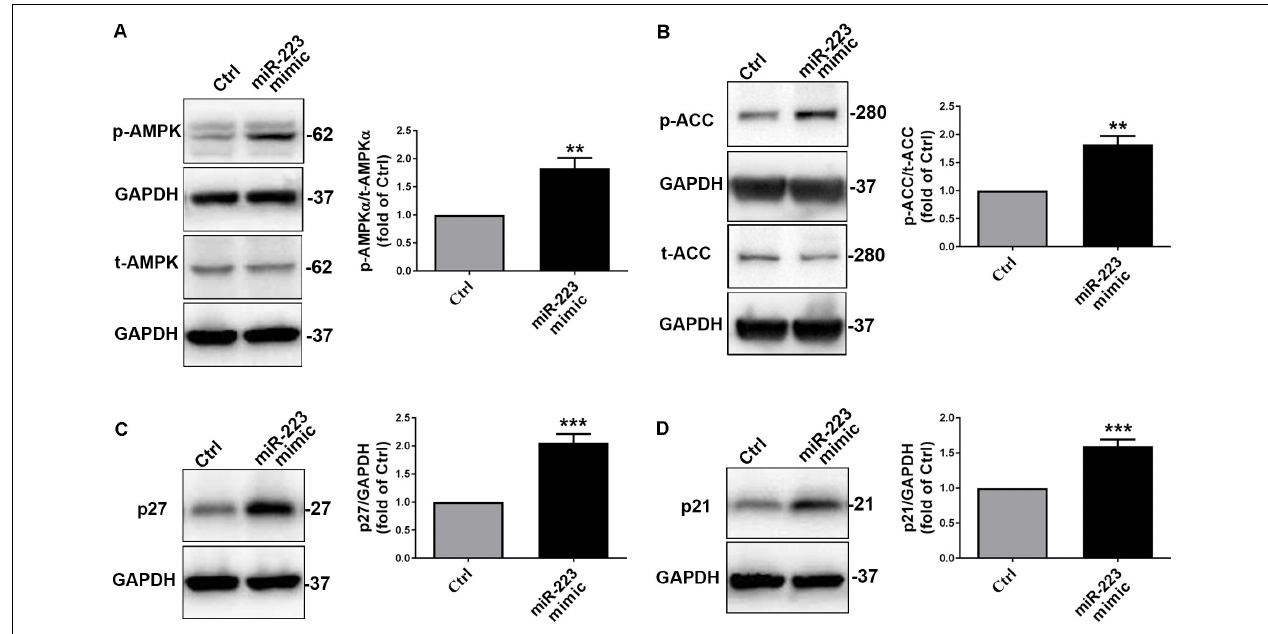
FIGURE 4 | The platelet-derived miR-223 suppressed VSMC proliferation via the regulation AMPK signaling pathways. VSMCs were transfected with miR-223 mimic for 48 h. (A,B) The phosphorylation of AMPK α and ACC were assessed by western blot analysis in VSMCs transfected with miR-223 mimic. (C,D) The expression of cell cycle marks including p27 and p21 was determined with western blot analysis in VSMCs transfected with miR-223 mimic. Data are presented as mean ± SD ( n = 6). Comparisons between two groups were analyzed using unpaired nonparametric Student’s t -test. * P < 0.05, ** P < 0.01, *** P < 0.001 vs Ctrl